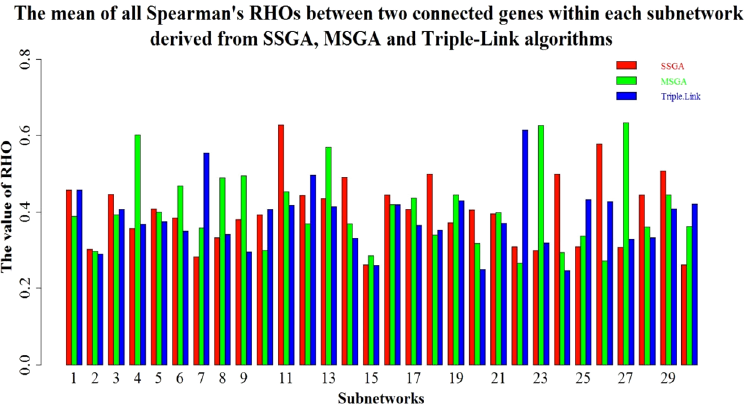
Figure 3. The mean of all Spearman’s rhos between two genes within each subnetwork derived from SSGA, MSGA and Triple-Link Algorithm. The TFs within a subnetwork with higher mean of rho values are more highly coordinated than those within a subnetwork with lower mean of rho